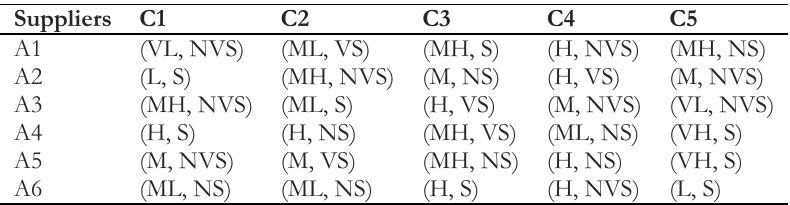
Table 3. Linguistic preferences of Expert 1 [16].